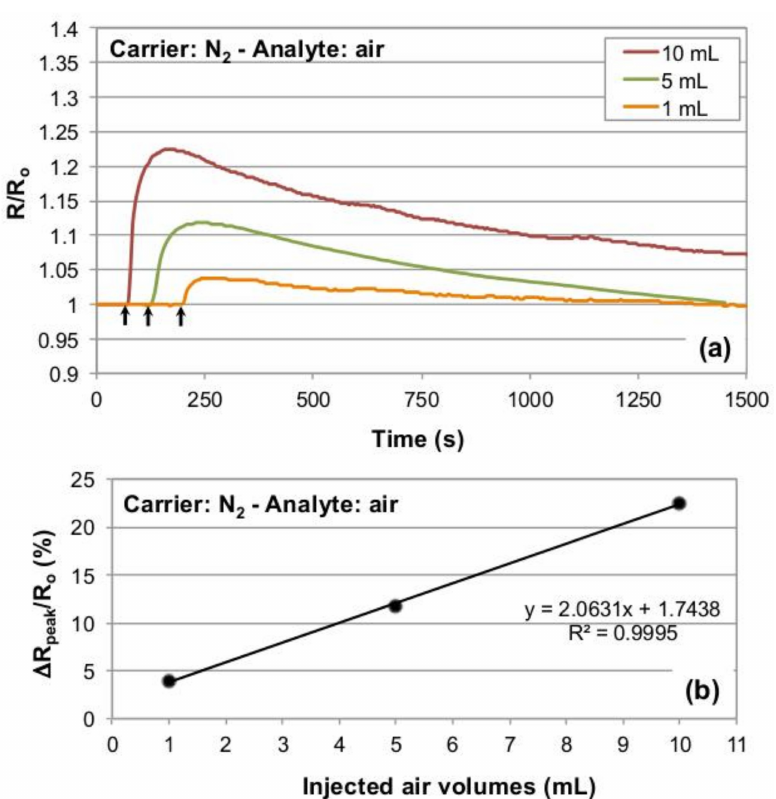
Figure 2. ( a ) Normalized resistance traces obtained from a Figaro commercial sensor operated in nitrogen and exposed to different amounts of laboratory air at 25 ◦ C. As it can be noticed, increasing injected volumes result in progressively higher peak heights. The black arrows mark the end of the analyte injection procedure (approximately three-four seconds prior to observe the sensor response onset. This relatively long time is attributed to the steel mesh protecting the Figaro sensing surface, see the Discussion part for details). ( b ) Percentage resistance change with respect to baseline for the injected gas analyte volumes used to validate the testing